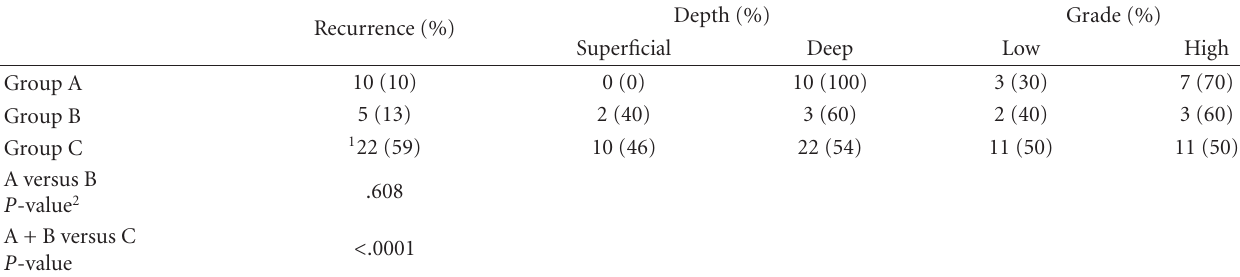
Table 2: Characteristics of the STS in the di ff erent groups according to recurrence.